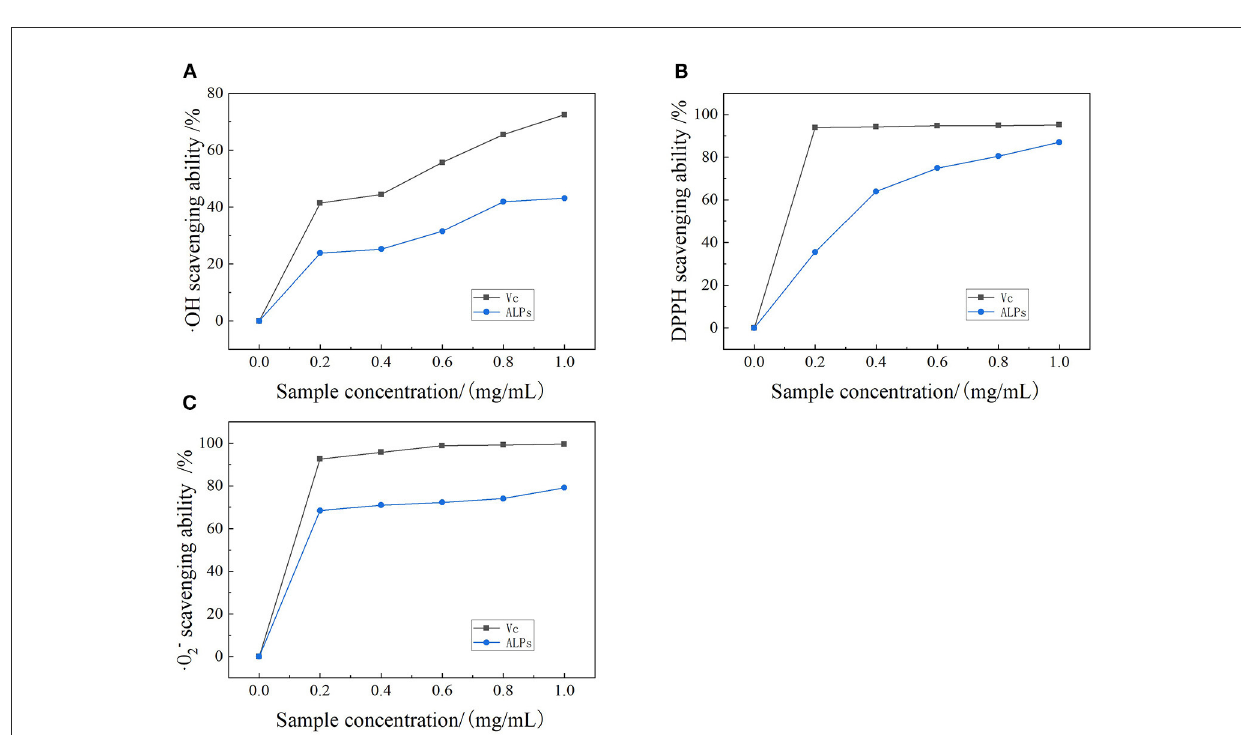
FIGURE6 Scavenging effect of ALPs on (A) the · OH radicals compared with V C , (B) the DPPH radicals compared with V C , and (C) the · O − 2 radicals compared with V C